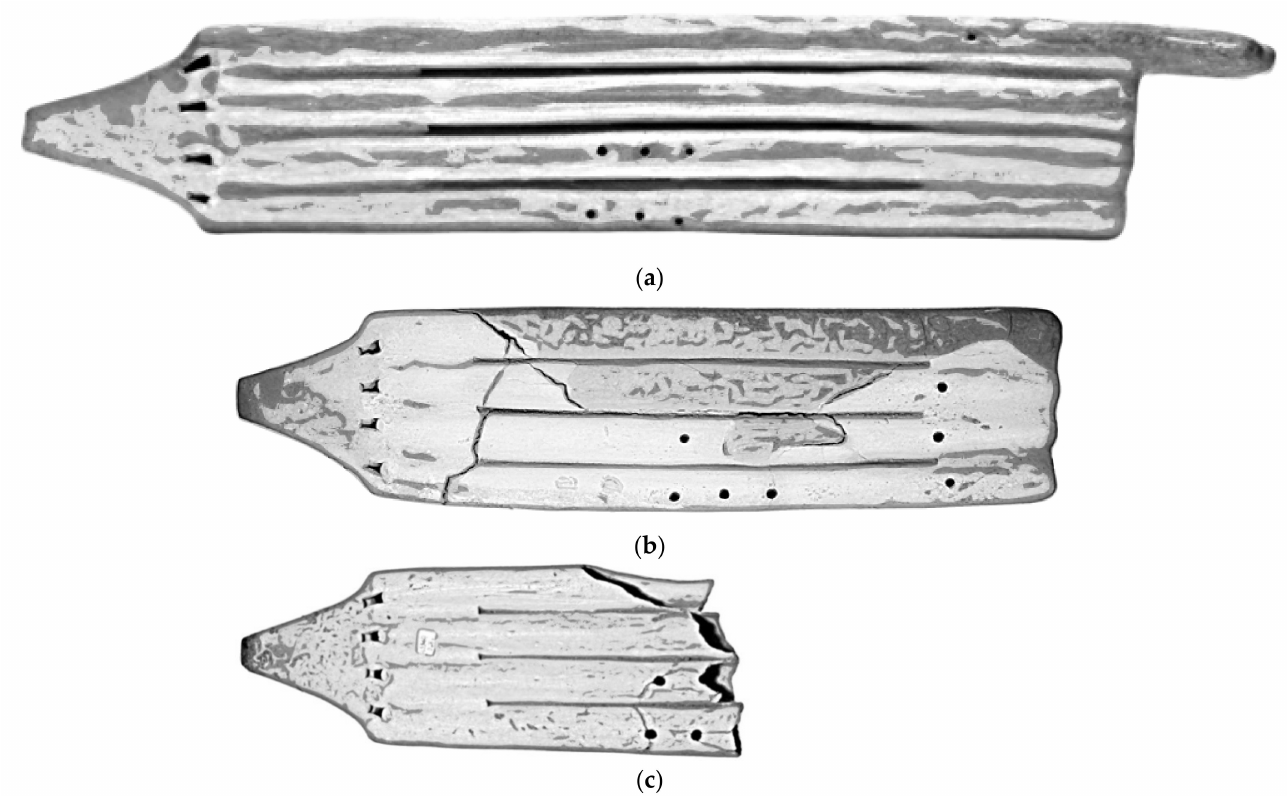
Figure 20. Quadruple flute finds from Teotihuacan: ( a ) Zacuala Palace (MNA, Inv. 10-223540), length: 74.5 cm; ( b ) Diego Rivera collection, “Anahuacalli 1” (MA, Inv. 51125), length: 43.0 cm; ( c ) fragment from the Diego Rivera collection, “Anahuacalli 2” (MA, Inv. 45540), length: 28